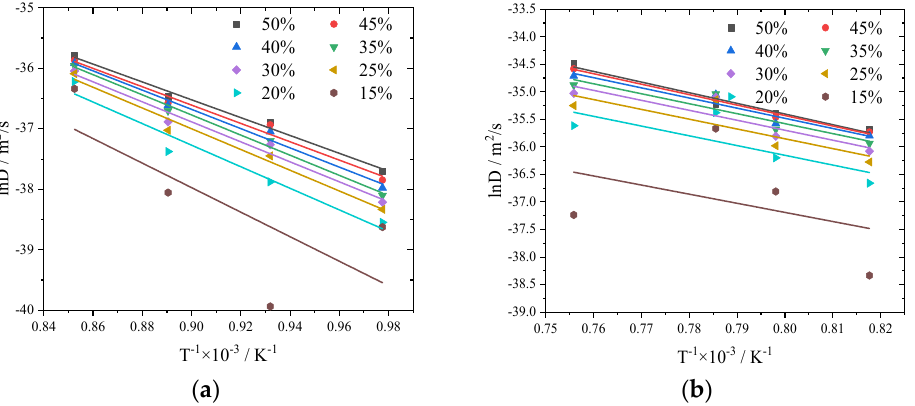
Figure 8. The changing of ln D with Cu concentration at different temperatures: ( a ) phase transition zone; ( b ) austenite phase zone. Figure 8a,b are the relationship between ln D and 1/ T in phase transformation zone and austenite phase zone separately. The relationships have been linearly fitted, and the the straight line, and the result are shown in Figure 9.